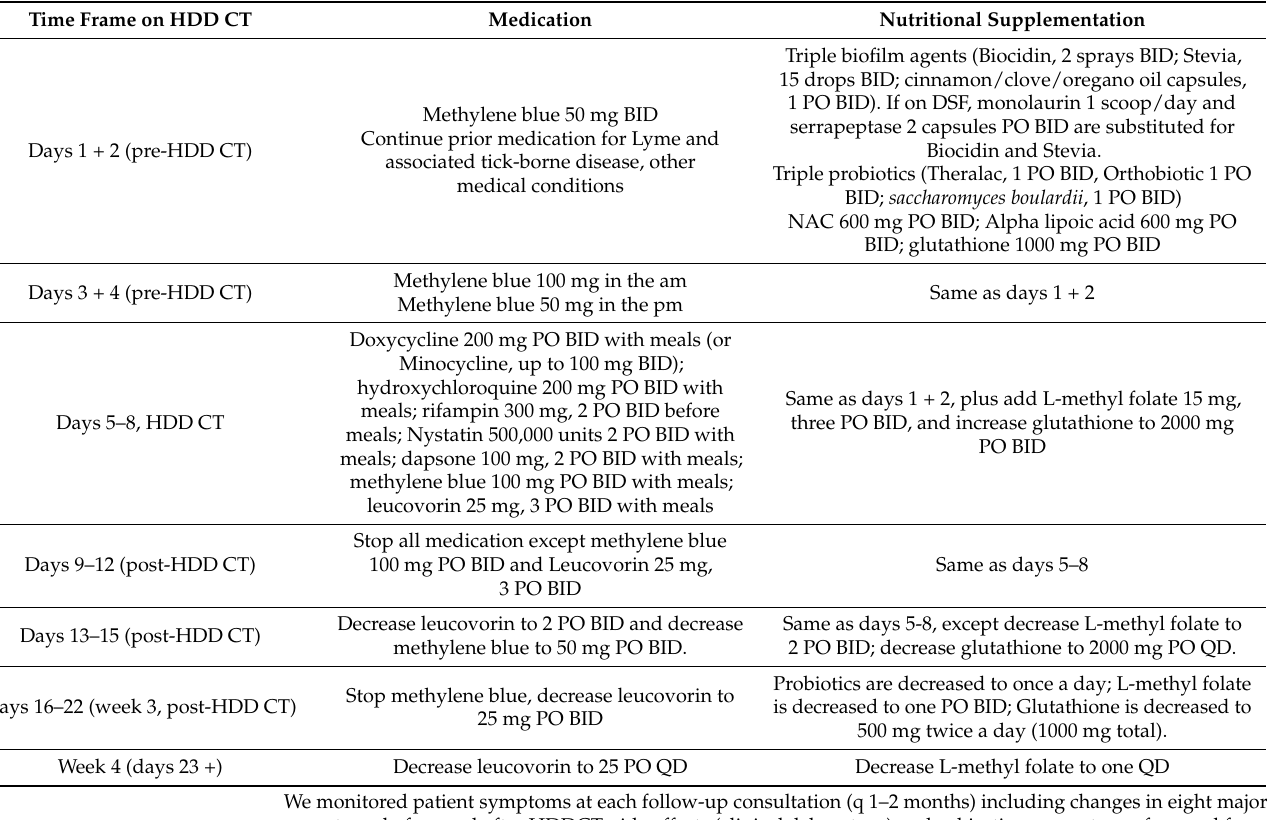
Table 1. Medication and nutritional supplementation that were used during high dose pulsed dapsone combination